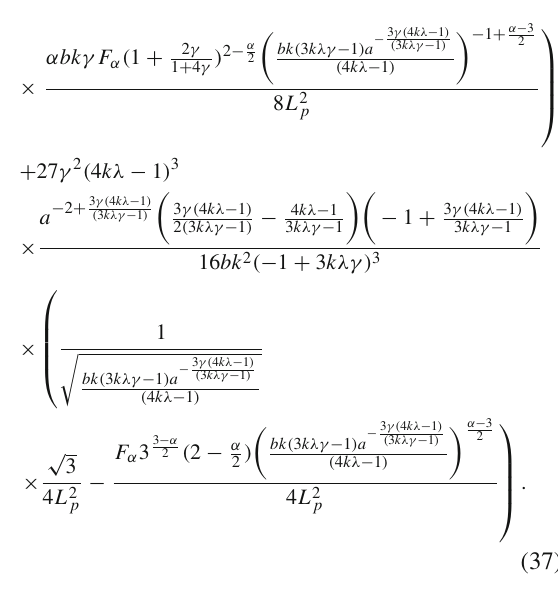
(cid:7)(cid:7) versus scale factor for T